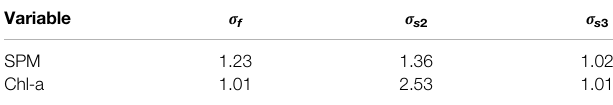
TABLE 4 | Results of the triple-collocation technique applied to standardized anomalies of fi eld measurements and satellite derived concentrations of SPM and Chl-a. With σ being the standard deviation, and the subscripts, f , s 2, and s 3 representing fi led, S2-MSI, and S3-OLCI data, respectively. Variable